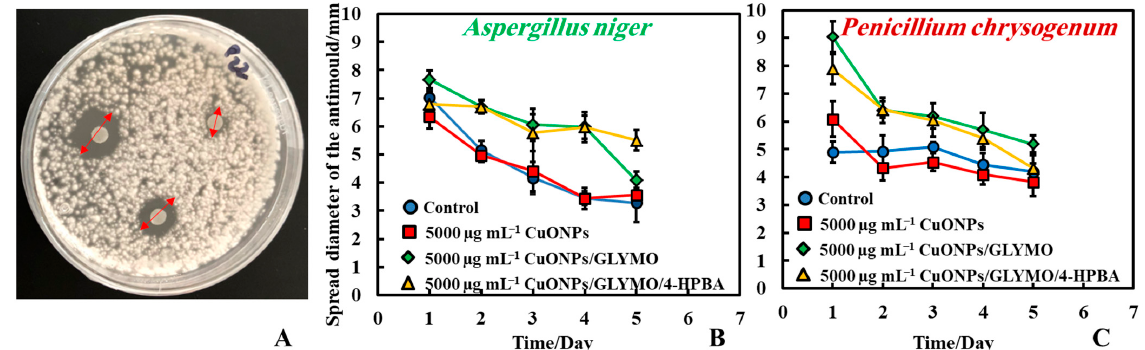
Figure 4. ( A ) Digital photograph of the PDA–gel plate for Method 2, showing the measured size of the mould growth inhibition zone around the antimould agent sample. Here, the paper discs were impregnated with the antimould agent, while the whole gel plate was seeded with a mould suspension. Graphs of the growth inhibition zone diameter of the antimould with ( B ) A. niger and ( C ) P. chrysogenum , over the whole PDA–gel plate as a function of time. The solid lines are guides to the eye.